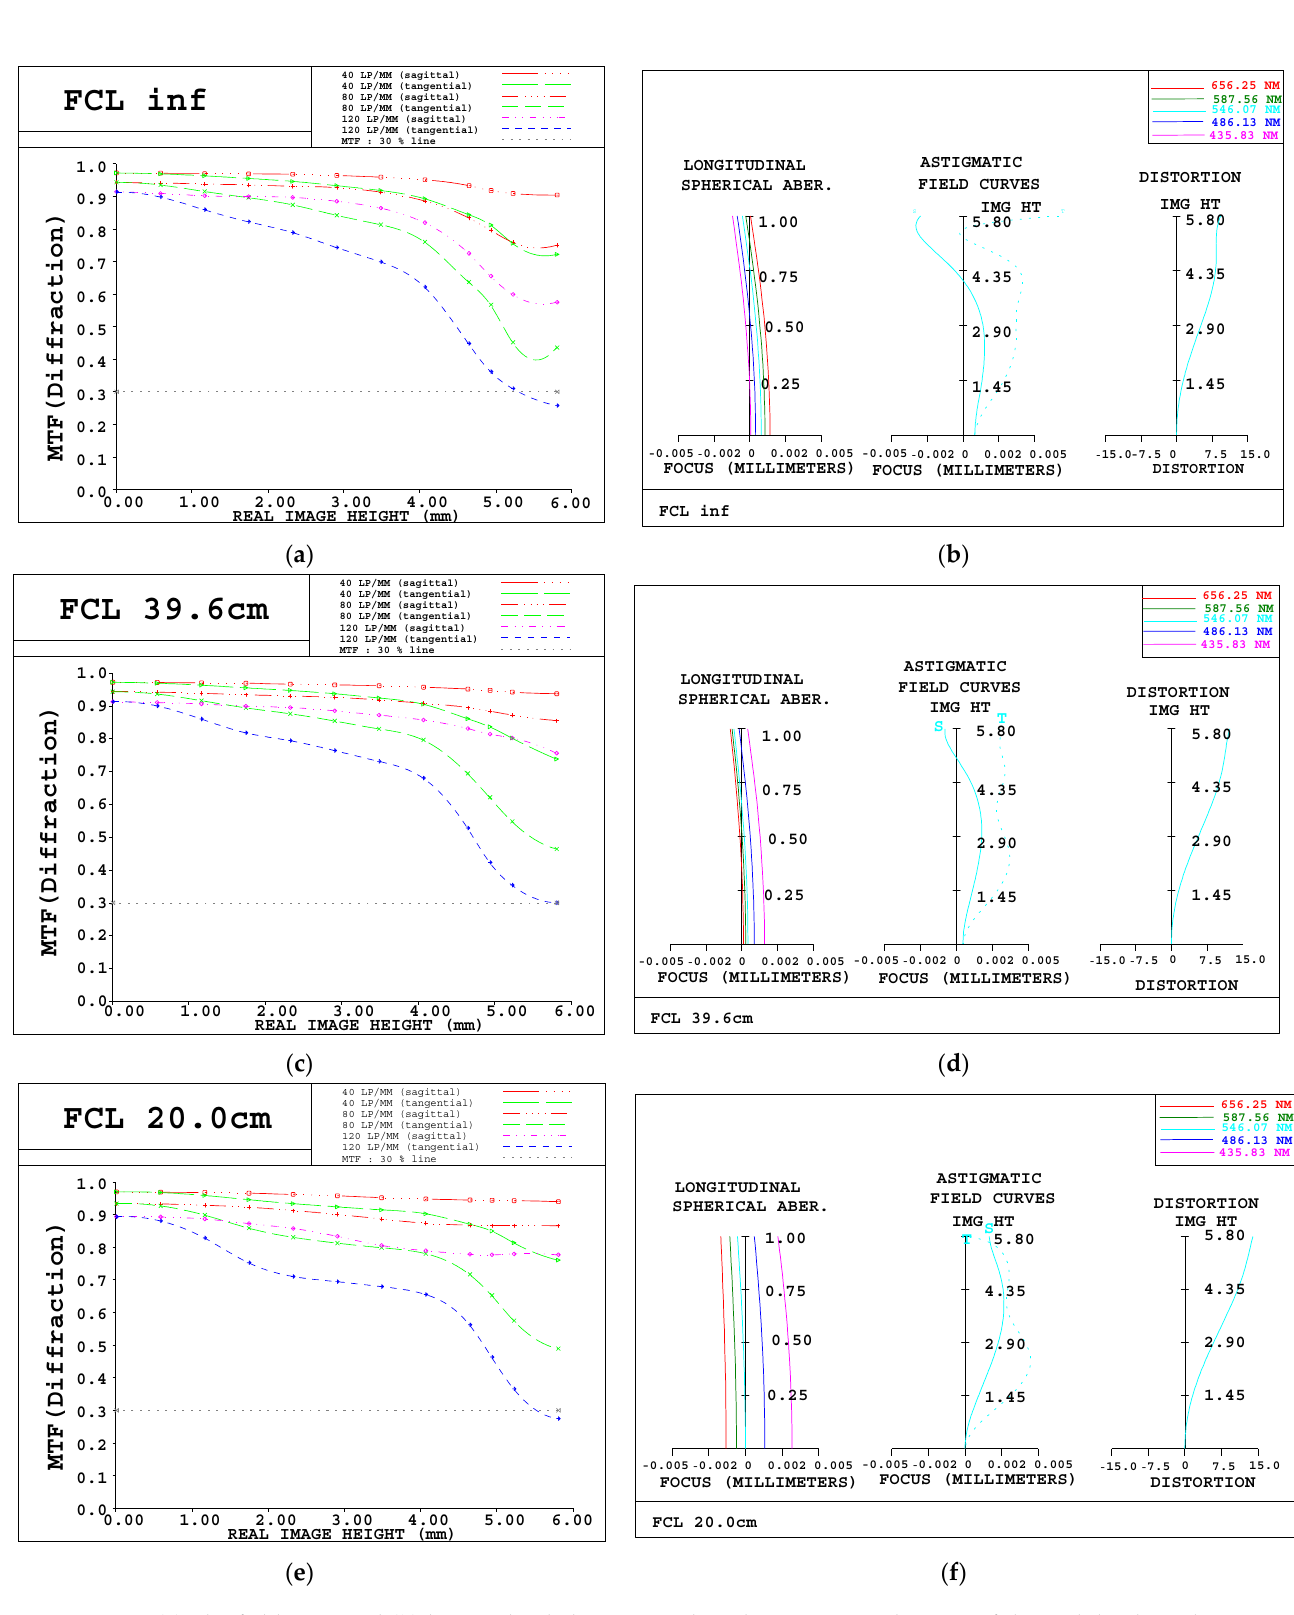
Figure 5. ( a ) The field MTF and ( b ) longitudinal aberration when the inspection distance of the mobile phone lens is infinite. ( c ) The field MTF and ( d ) longitudinal aberration when the inspection distance is 396 mm. ( e ) The field MTF and ( f ) longitudinal aberration when the inspection distance is 200 mm. of all lens groups. Equations (1) and (3) must be used to determine the locus. All lens